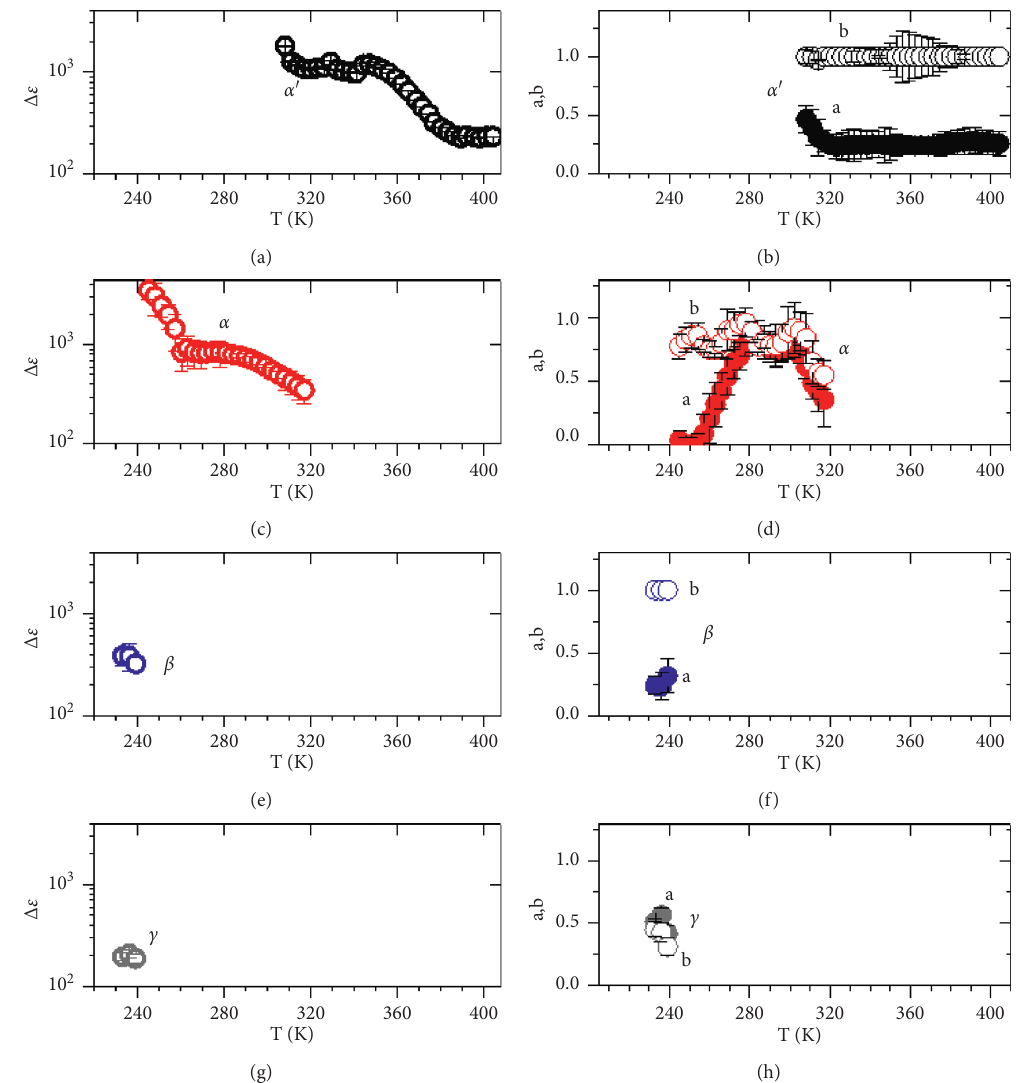
Figure 6: Temperature dependence of the relaxation strength and shape parameter for the four relaxation processes in